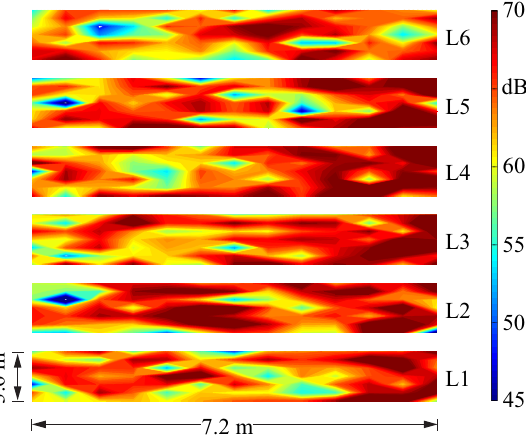
Figure 13: Sound pressure level map primary noise field at h / λ =0.18 .